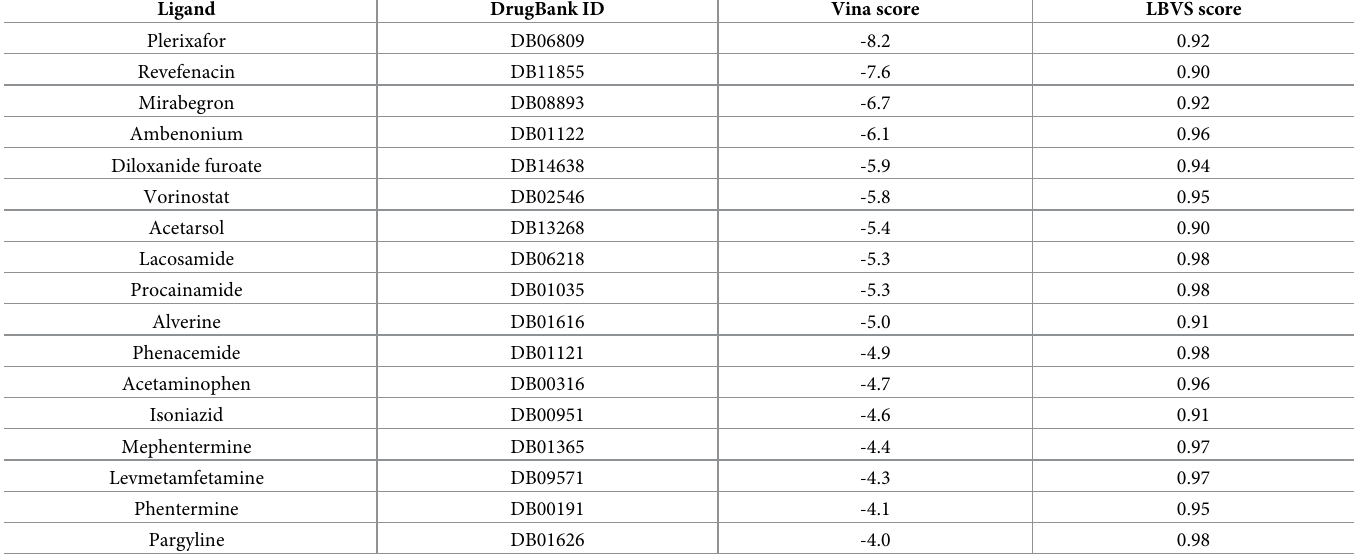
Table 3. Top-scored ligands for SARS-COV-2 M pro selected for docking calculation in Autodock vina. Ligand DrugBank